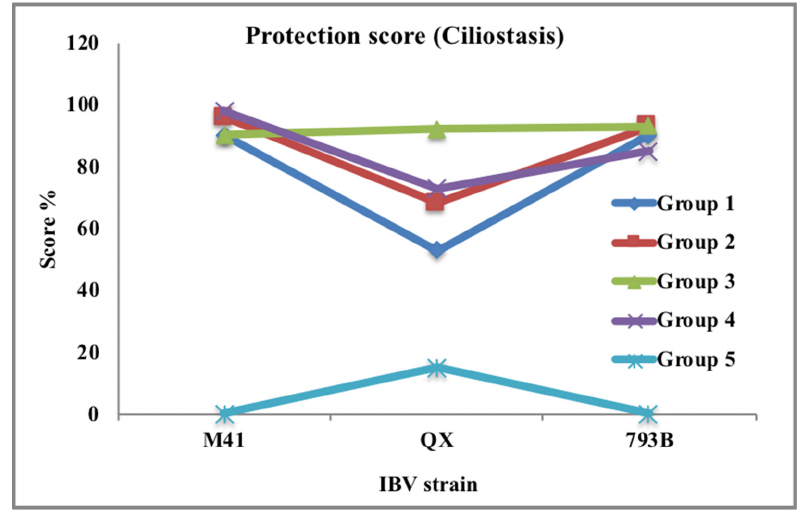
Figure 3. Ciliary protection stimulated by infectious bronchitis virus (IBV) vaccination programs against three virulent IBV strain challenges on day 21 post vaccine. IBV vaccination programs categorized into Group 1 = Mass1 + D274, Group 2 = Mass1 + 793B1, Group 3 = Mass2 + 793B2, Group 4 = Mass3 + Ark, and Group 5 = sterile water (SW). In this study, the monovalent Mass vaccines (H120 or Ma5) are referred to as Mass1 and Mass2, and the 793B vaccines are referred to as 793B1 and 793B2 (4/91 or CR88) serotypes. IBV challenged by M41, QX, or 793B initiated severe ciliostasis in unvaccinated–challenged birds. Ciliary scores indicated that vaccination programs gave good protection (>85%) against M41 and 793B. However, Group 3 (Mass2 + 793B2) was the only group to show good protection against QX; other groups were under partial protection. Protection score curve indicated that the higher the score was, the better the protection (Source: Awad et al.